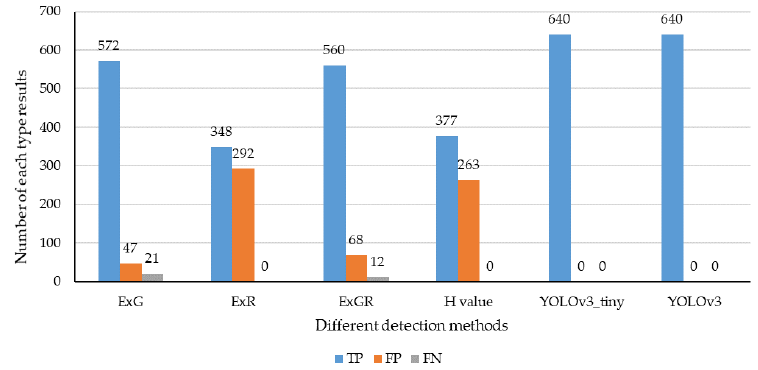
Figure 10. Results of different detection methods.